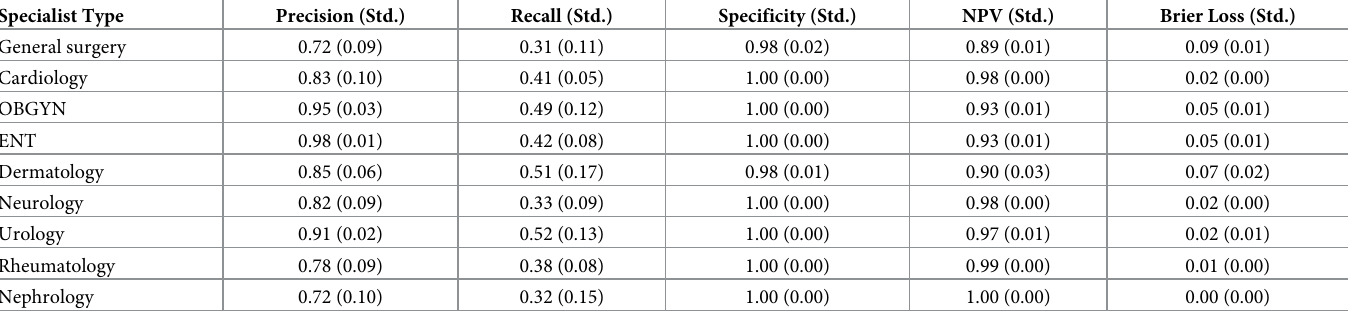
Table 4. Precision, recall, specificity, negative predictive value (NPV), and Brier score loss for the models which we used for prediction. The standard deviations for each measurement are presented between parentheses.